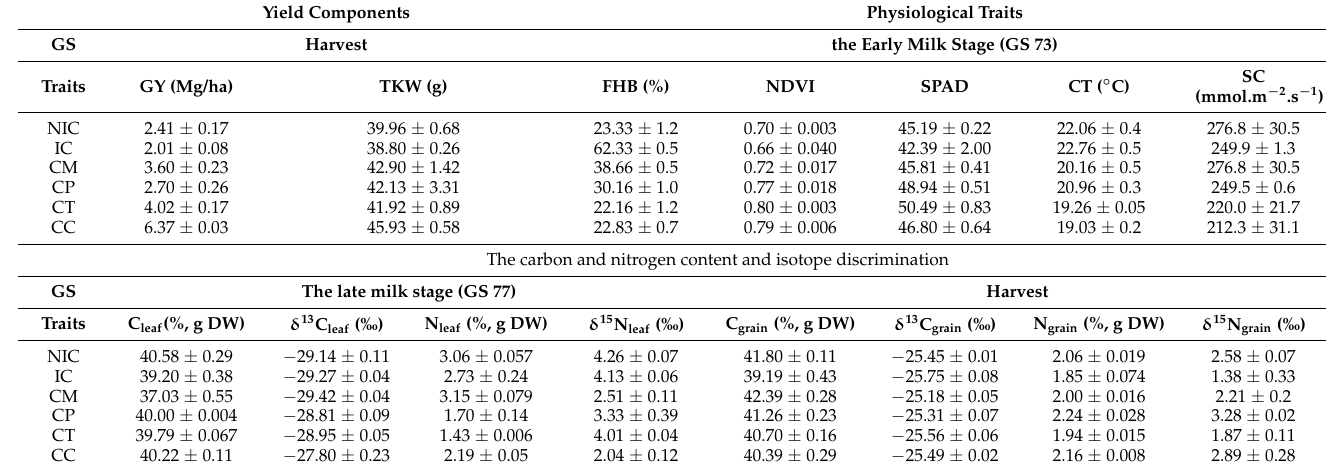
Figure 2. The Pearson’s correlation matrix among physiological traits, Fusarium head blight severity, yield components and grain stable isotope composition (2018 field trial). Traits; C: carbon, N: nitrogen, 13C: δ 13C, 15N: δ 15N, GY: grain yield, TKW: thousand kernel weight, CT: canopy temperature, F severity: Fusarium head blight severity, SC: stomatal conductance. The darker, bigger blue squares indicate a stronger positive correlation. The darker, bigger red squares indicate a stronger negative correlation. Crossed cells indicate statistically insignificant correlations. Black rectangles indicate the traits that have a similar pattern of correlation according to hierarchical clustering. Table 5. Effect of the biostimulants on the physiological traits and carbon and nitrogen isotope discrimination in the 2018 cropping